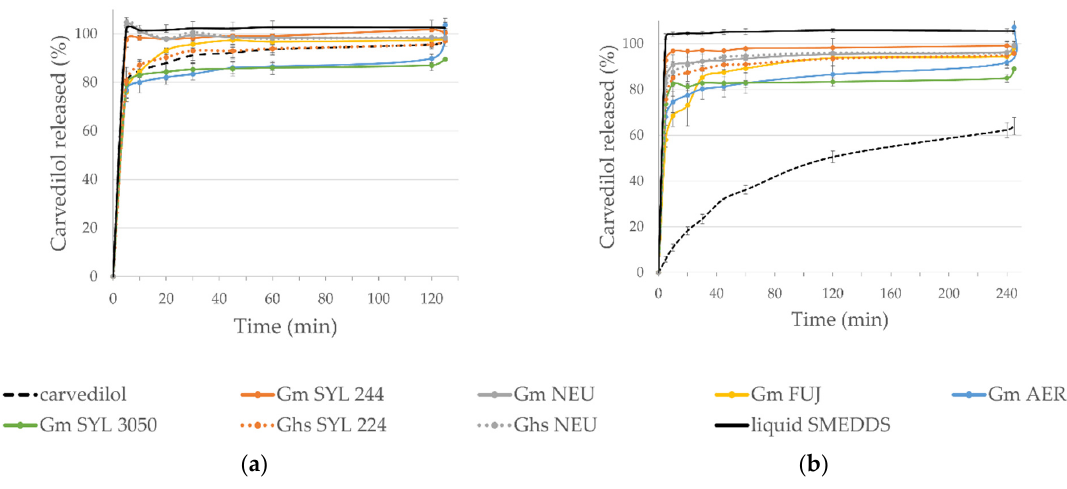
Figure 6. In vitro carvedilol release profiles in dissolution media with pH : ( a ) 1.2 ; ( b ) 6.8; for all SMEDDS granules in reference to crystalline drug and liquid SMEDDS.